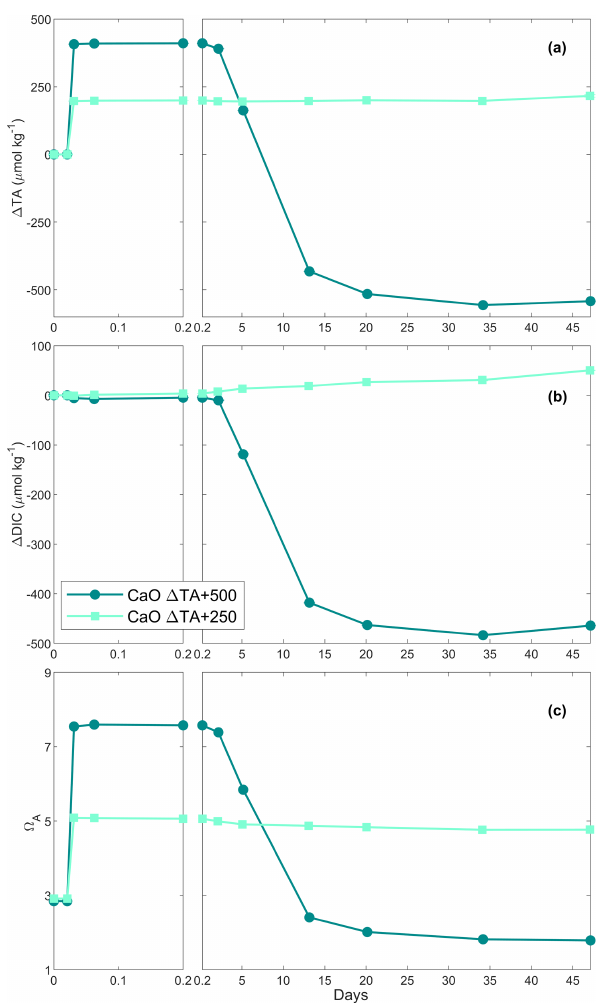
Figure 2. Changes in TA (a) , DIC (b) and (cid:127) A (c) of the samples over time following two Ca(OH) 2